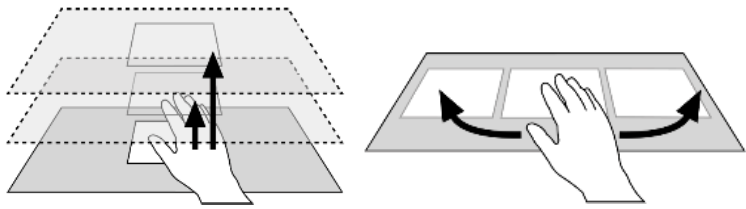
Figure 1. Electronic interactive mode of operation proposed by Lucero and Dima (Lucero, 2007).